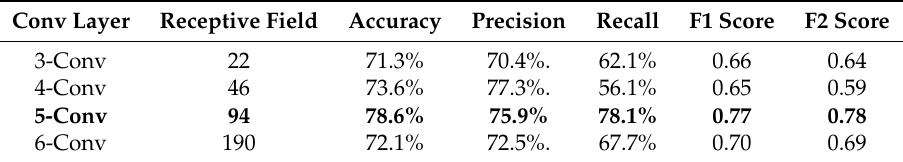
Table 3. Comparison between different convolutional layers with the same kernel size, and the 5-Conv layer is the most effective. (Kernel Size: 3 ×